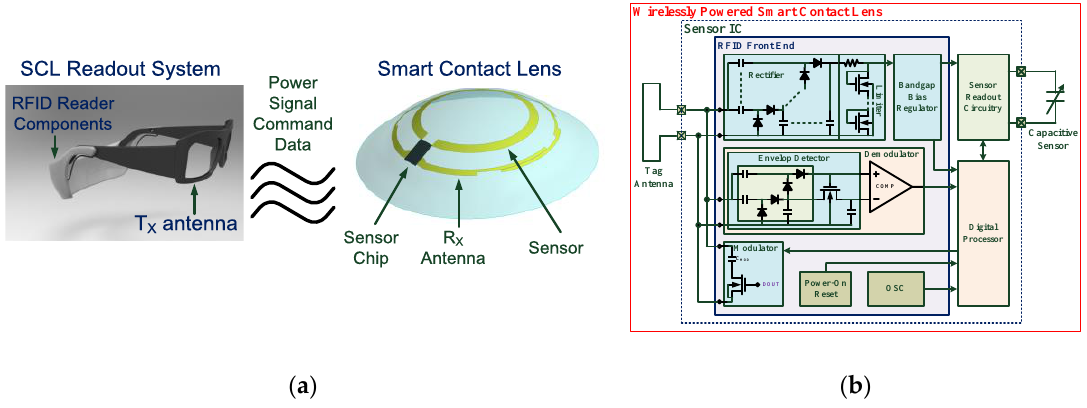
Figure 1. ( a ) Proposed smart contact lens (SCL) system architecture; ( b ) Block diagram of the proposed smart contact lens.